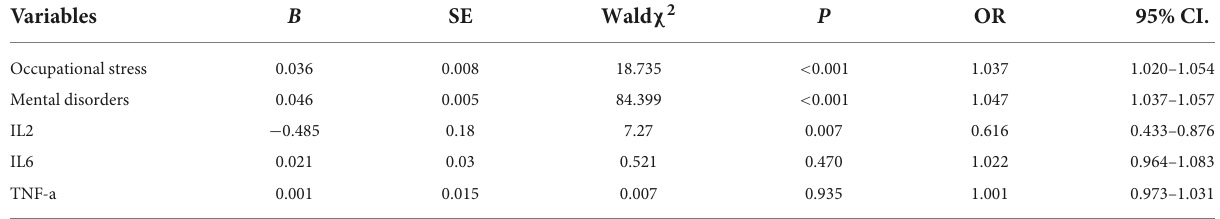
TABLE 6 Logistic regression analysis of the effects of occupational stress, mental disorders and cytokines on sleep disorders in oil workers.